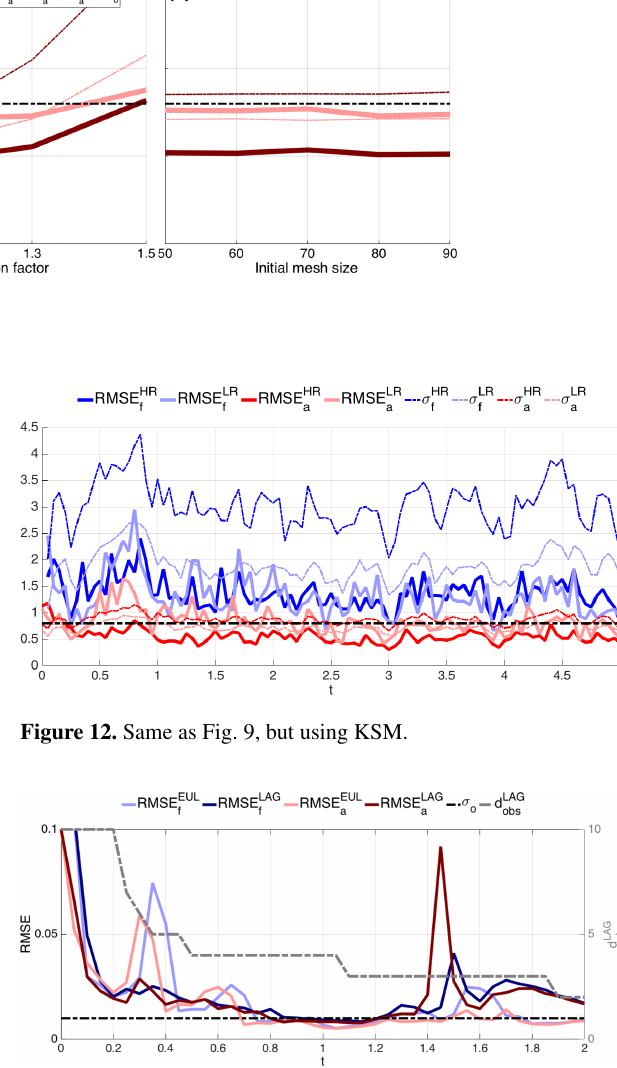
Figure 13. Time evolution of the RMSE until t = 2 using BGM. Light blue and red lines are the forecast and analysis RMSE with the Eulerian observations, respectively. Dark blue and gray lines are the same as the Lagrangian observations. Gray dashed line shows the number of Lagrangian observations in